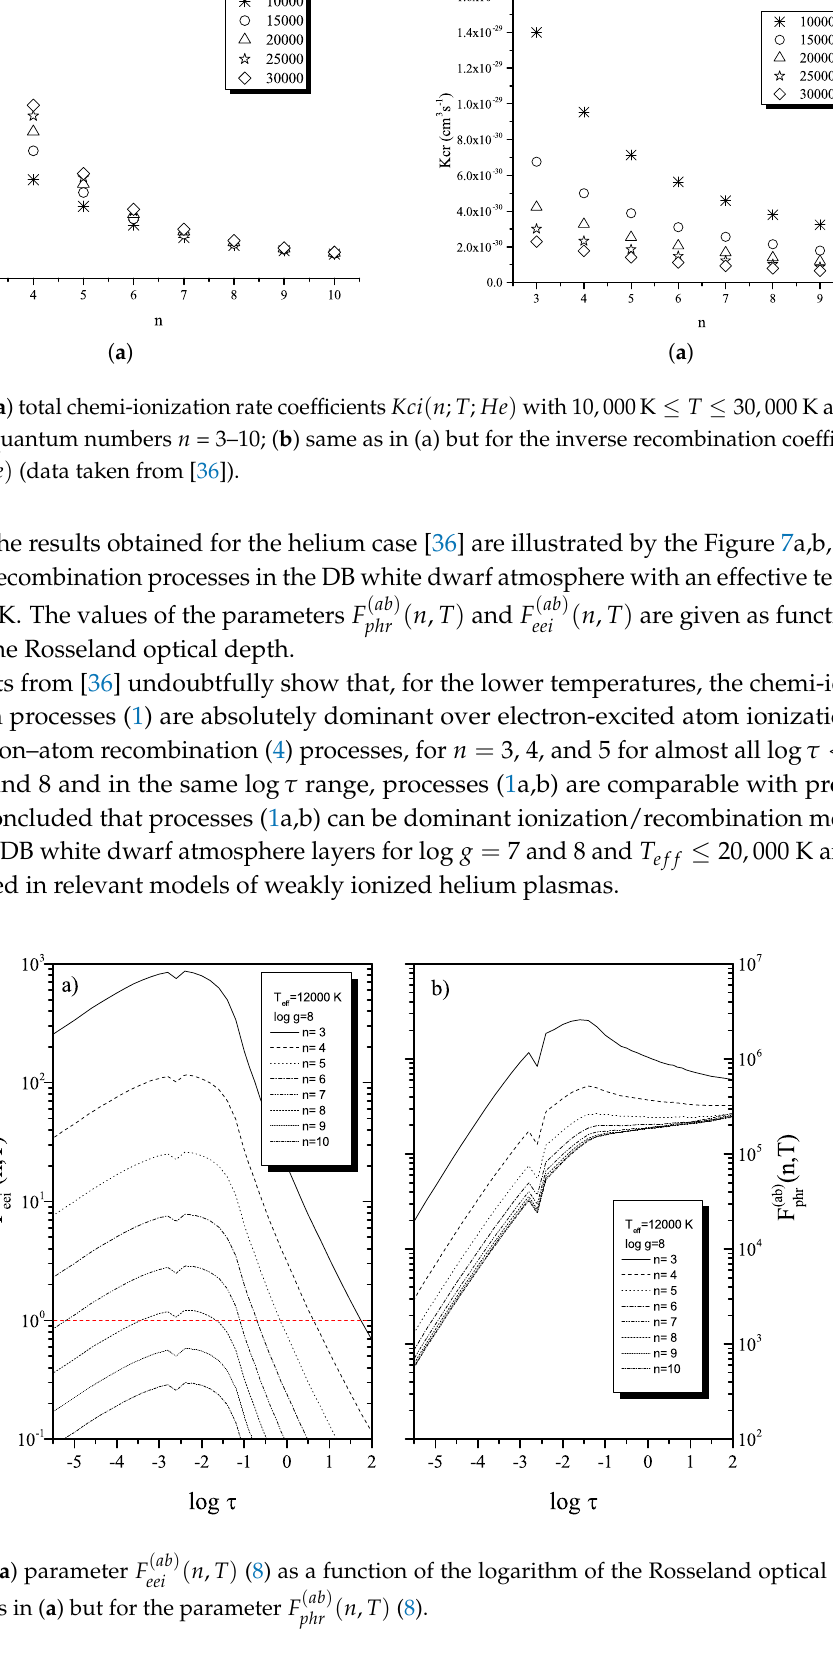
Figure 7. ( a ) parameter F log τ ; ( b ) as in ( a ) but for the parameter F